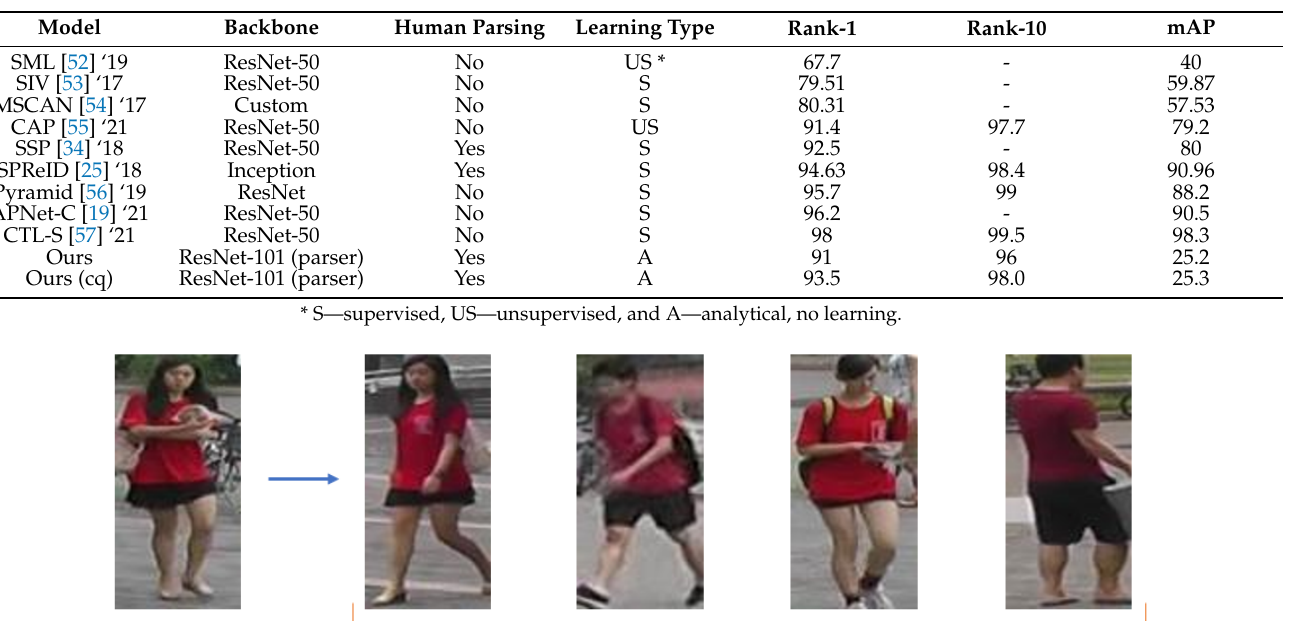
Table 4. Performance comparison on the Market1501 dataset.